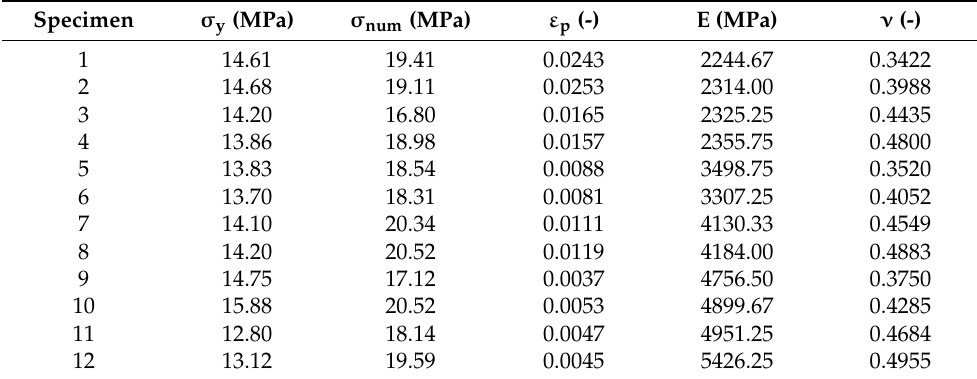
Table 5. Material properties for each specimen.